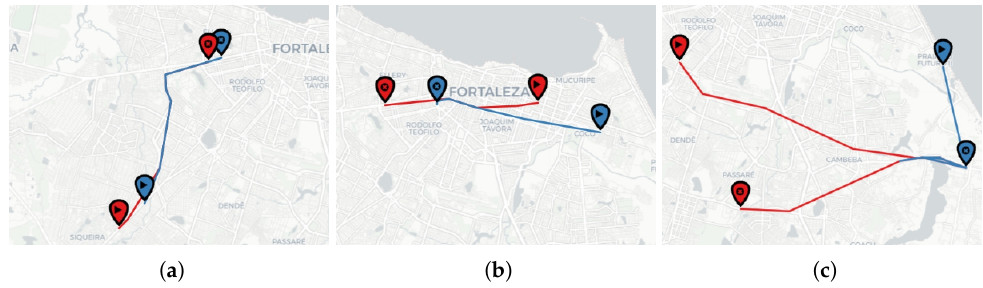
Figure 9. Example of most similar trajectories according to cosine distance between their embedding vectors. ( a ) High spatial similarity. ( b ) Medium spatial similarity. ( c ) Low spatial